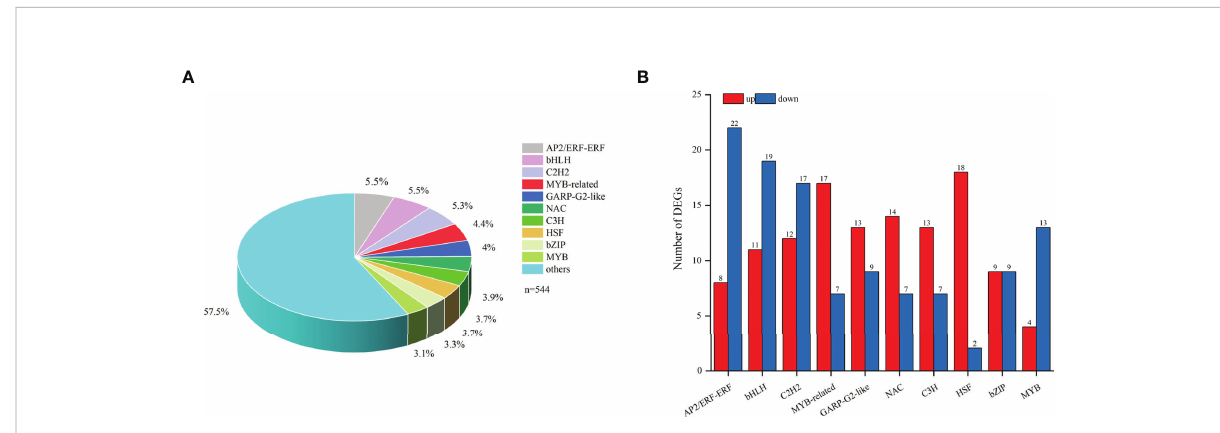
FIGURE 7 TFs DEGs involved in the synthesis of steroid alkaloids. (A) TFs. (B) Top10 TFs in samples under the I and M systems.